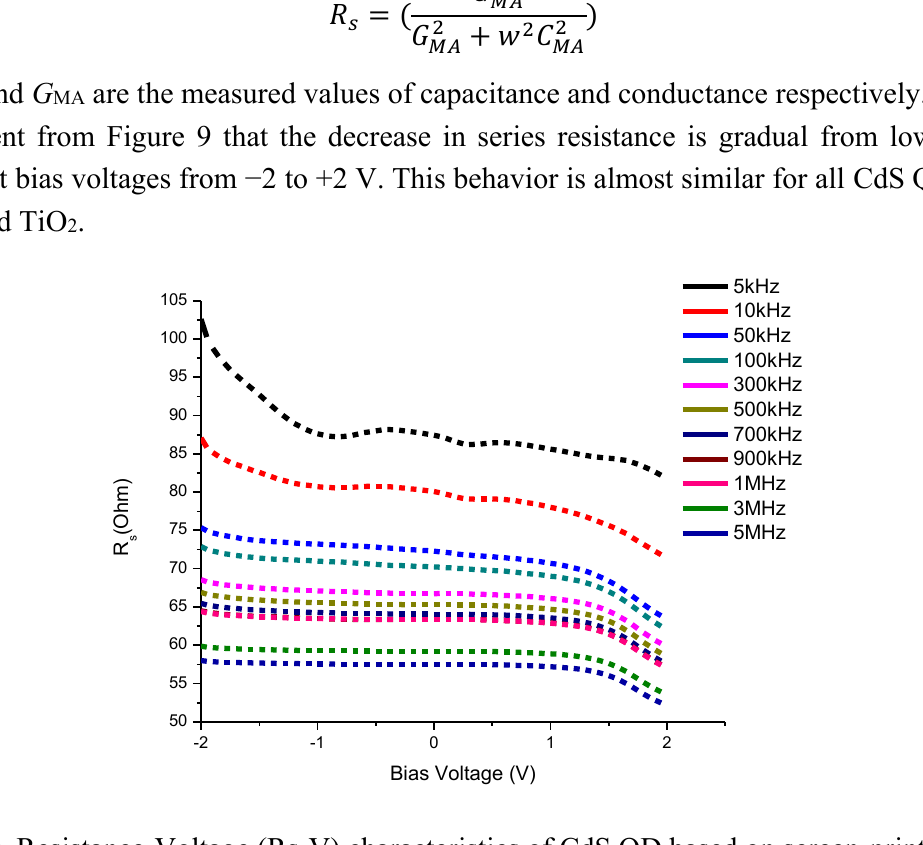
Figure 9. Resistance-Voltage (Rs-V) characteristics of CdS QD based on screen-printed TiO 2